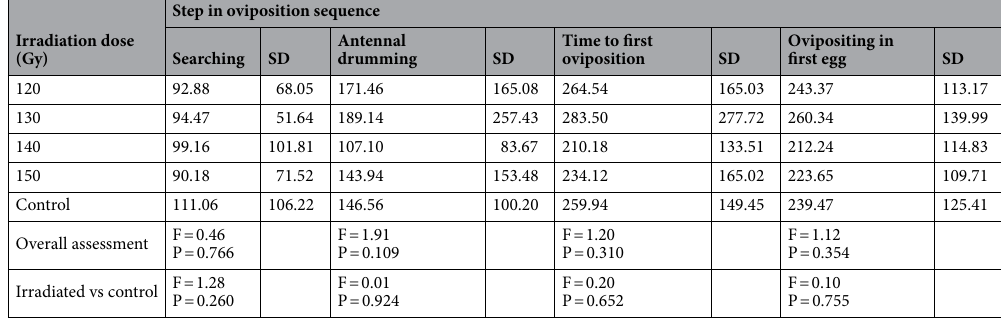
Step in oviposition